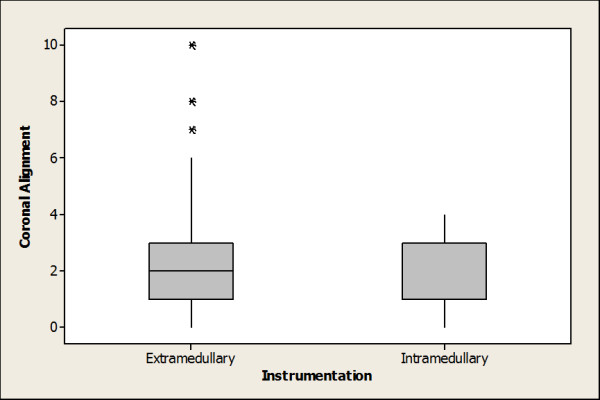
Coronal Alignment.